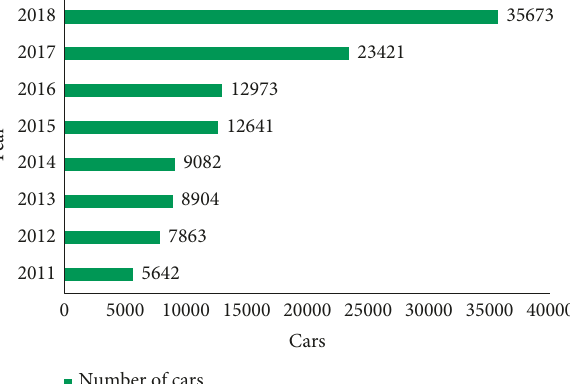
Figure 2: The number of people who bought a car, 2011–2018.